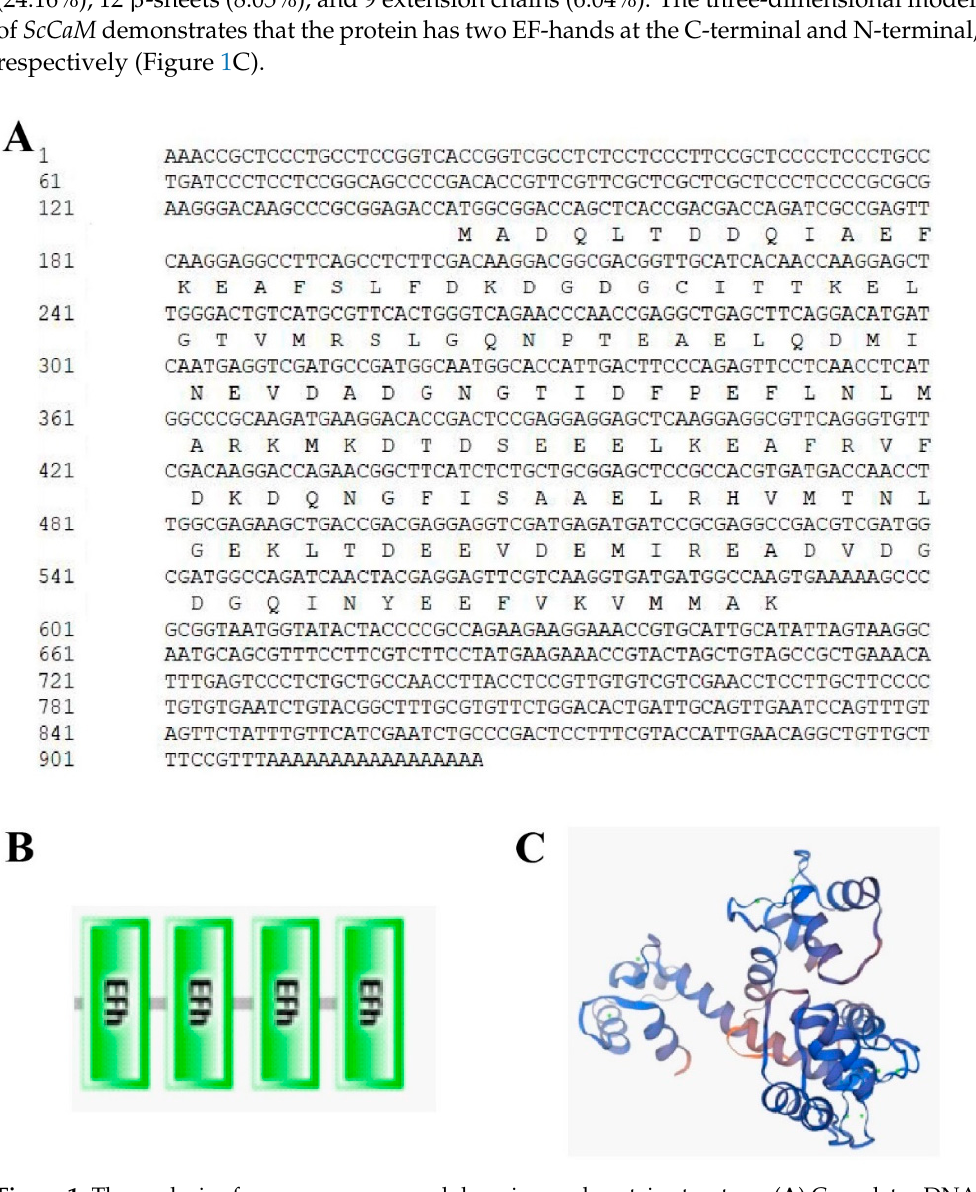
Figure 1. The analysis of sequence, conserved domains, and protein structure. ( A ) Complete cDNA and deduced amino acid sequences of the ScCaM gene. ( B ) The conserved domains of ScCaM . ( C ) The three-dimensional model of ScCaM .